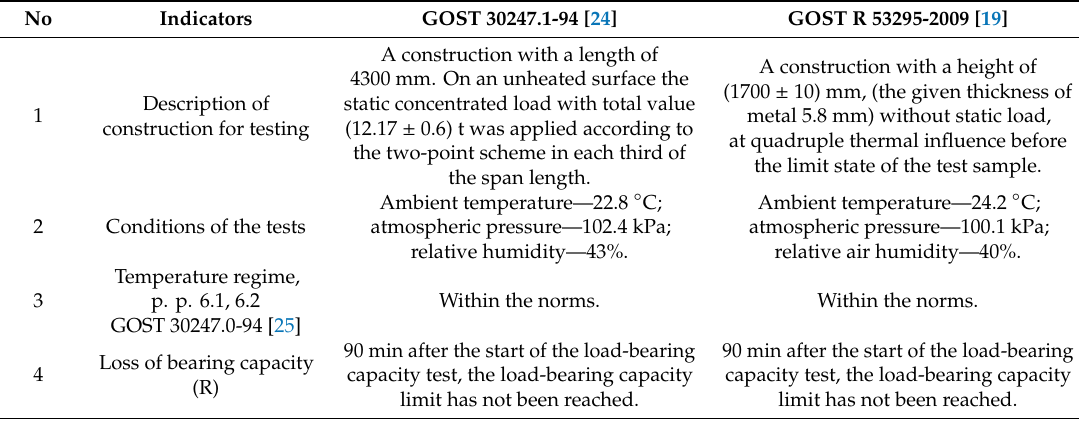
Table 5. Results of full-scale fire